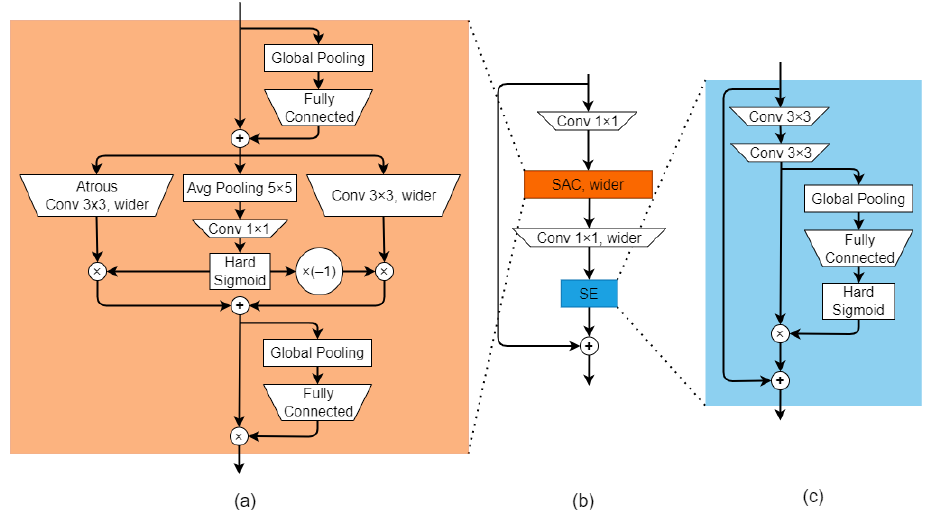
Figure 8. Wide Residual Blocks with Switchable Atrous Convolution: ( a )—SAC unit, the main disitinctive feature of which is the switching of two parallel branches: the branch with atrous convolution and the branch with plain convolution. The routing procedure is performed by multiplication with the hard feature maps sigmoid output of the middle branch of the SAC block; ( b )—an overall of Wide Residual Blocks with Switchable Atrous Convolution; ( c )—simplified Squeeze-and-Excitation unit [53], which consists of a fully connected layer, followed by hard sigmoid activation.